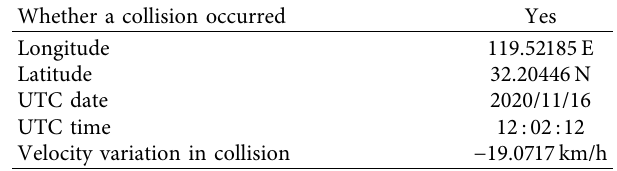
Table 19: Peak acceleration under typical working conditions. Table 20: Output of the traditional ACN algorithm.